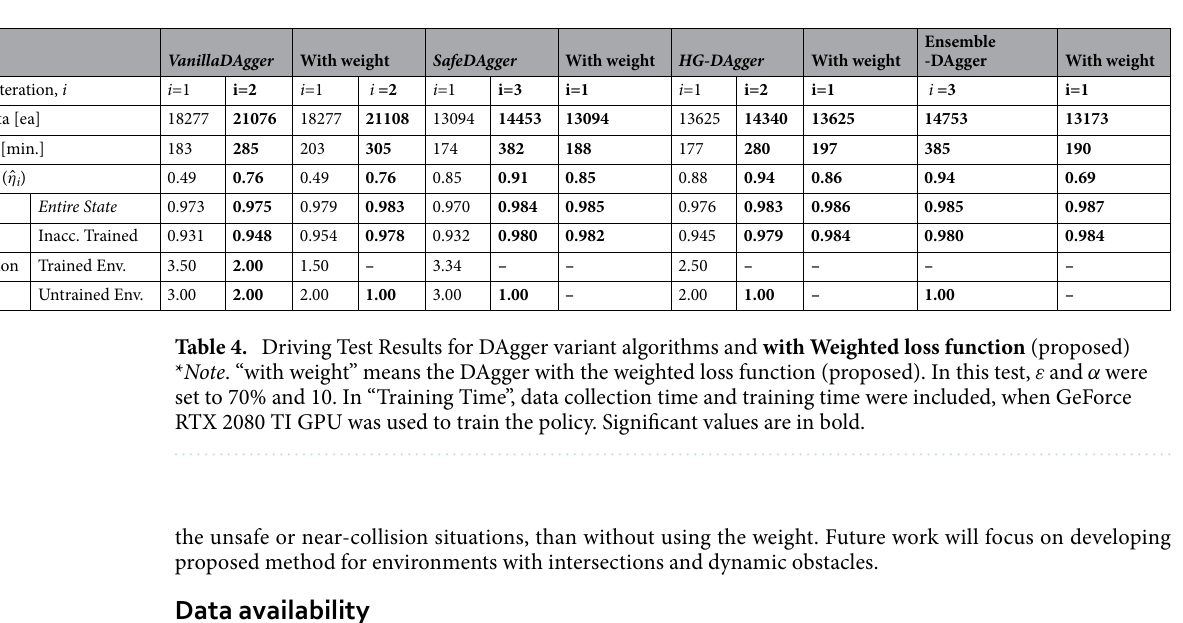
VanillaDAgger With weight SafeDAgger With weight HG-DAgger With weight